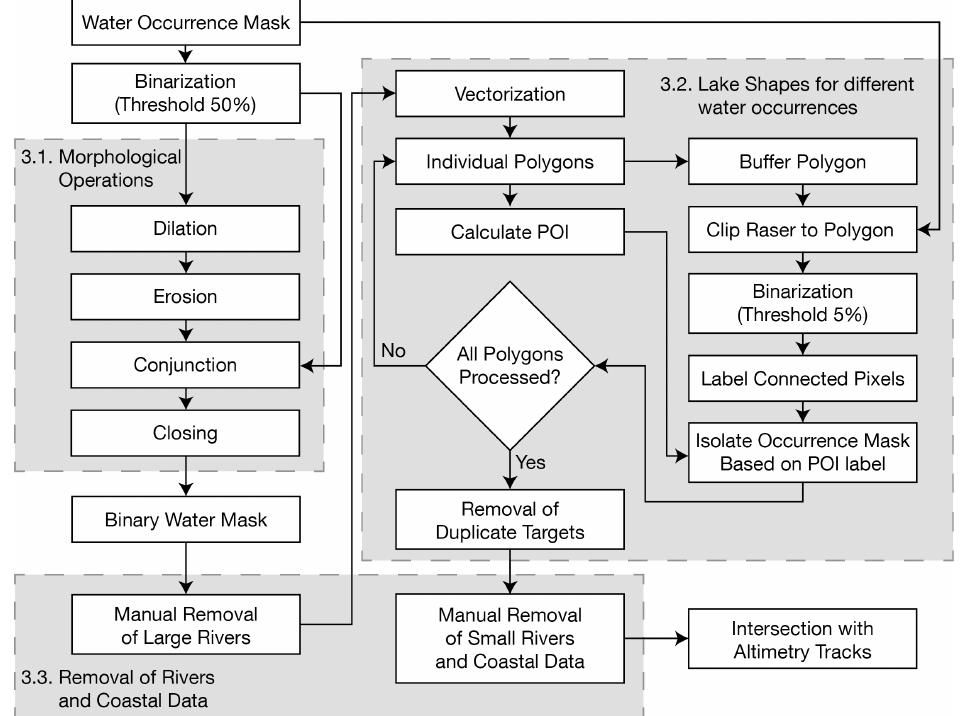
Figure A1. Flowchart of automated target detection, as described in Section